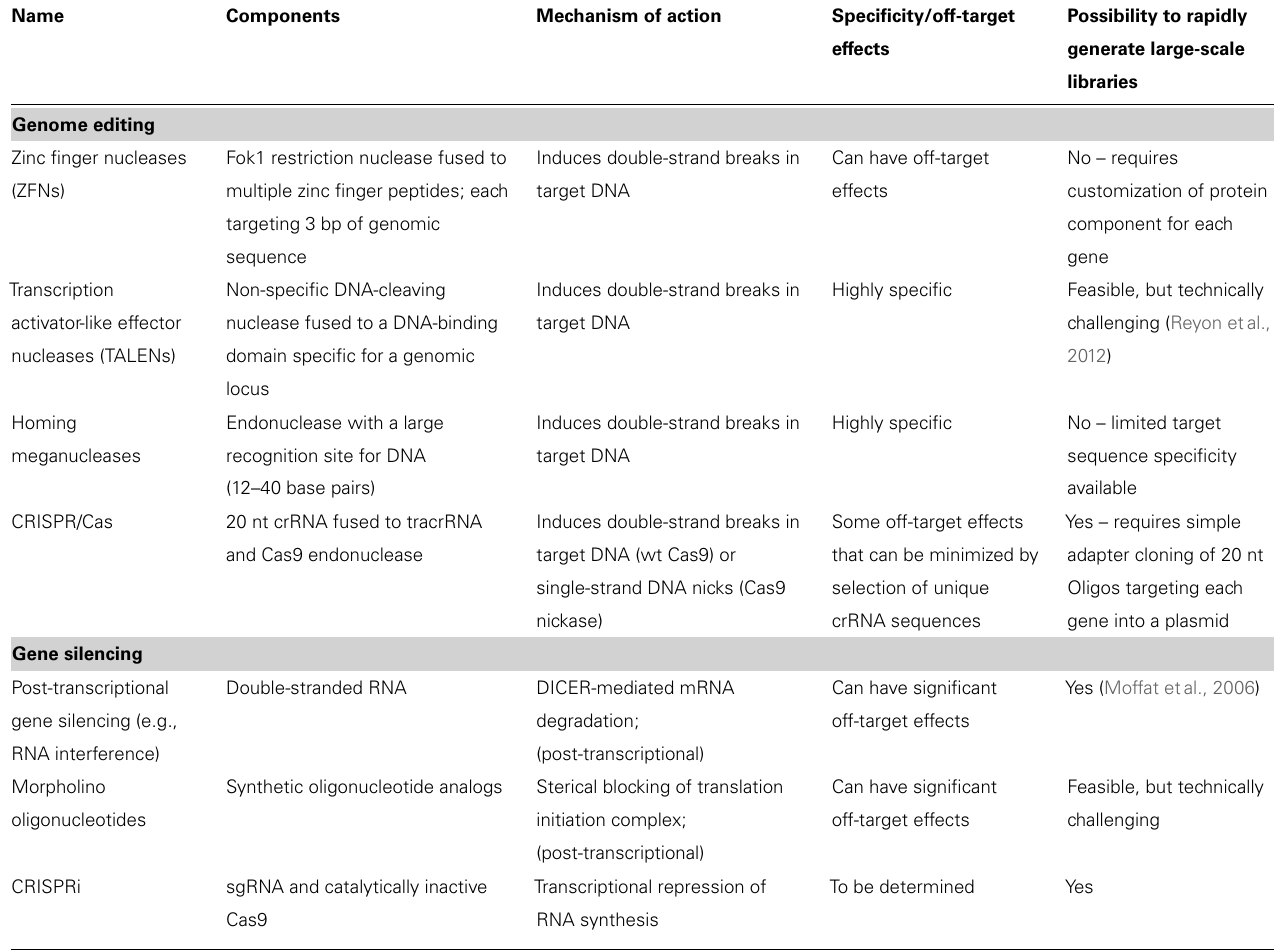
Table 1 | Overview of genome editing and gene silencing